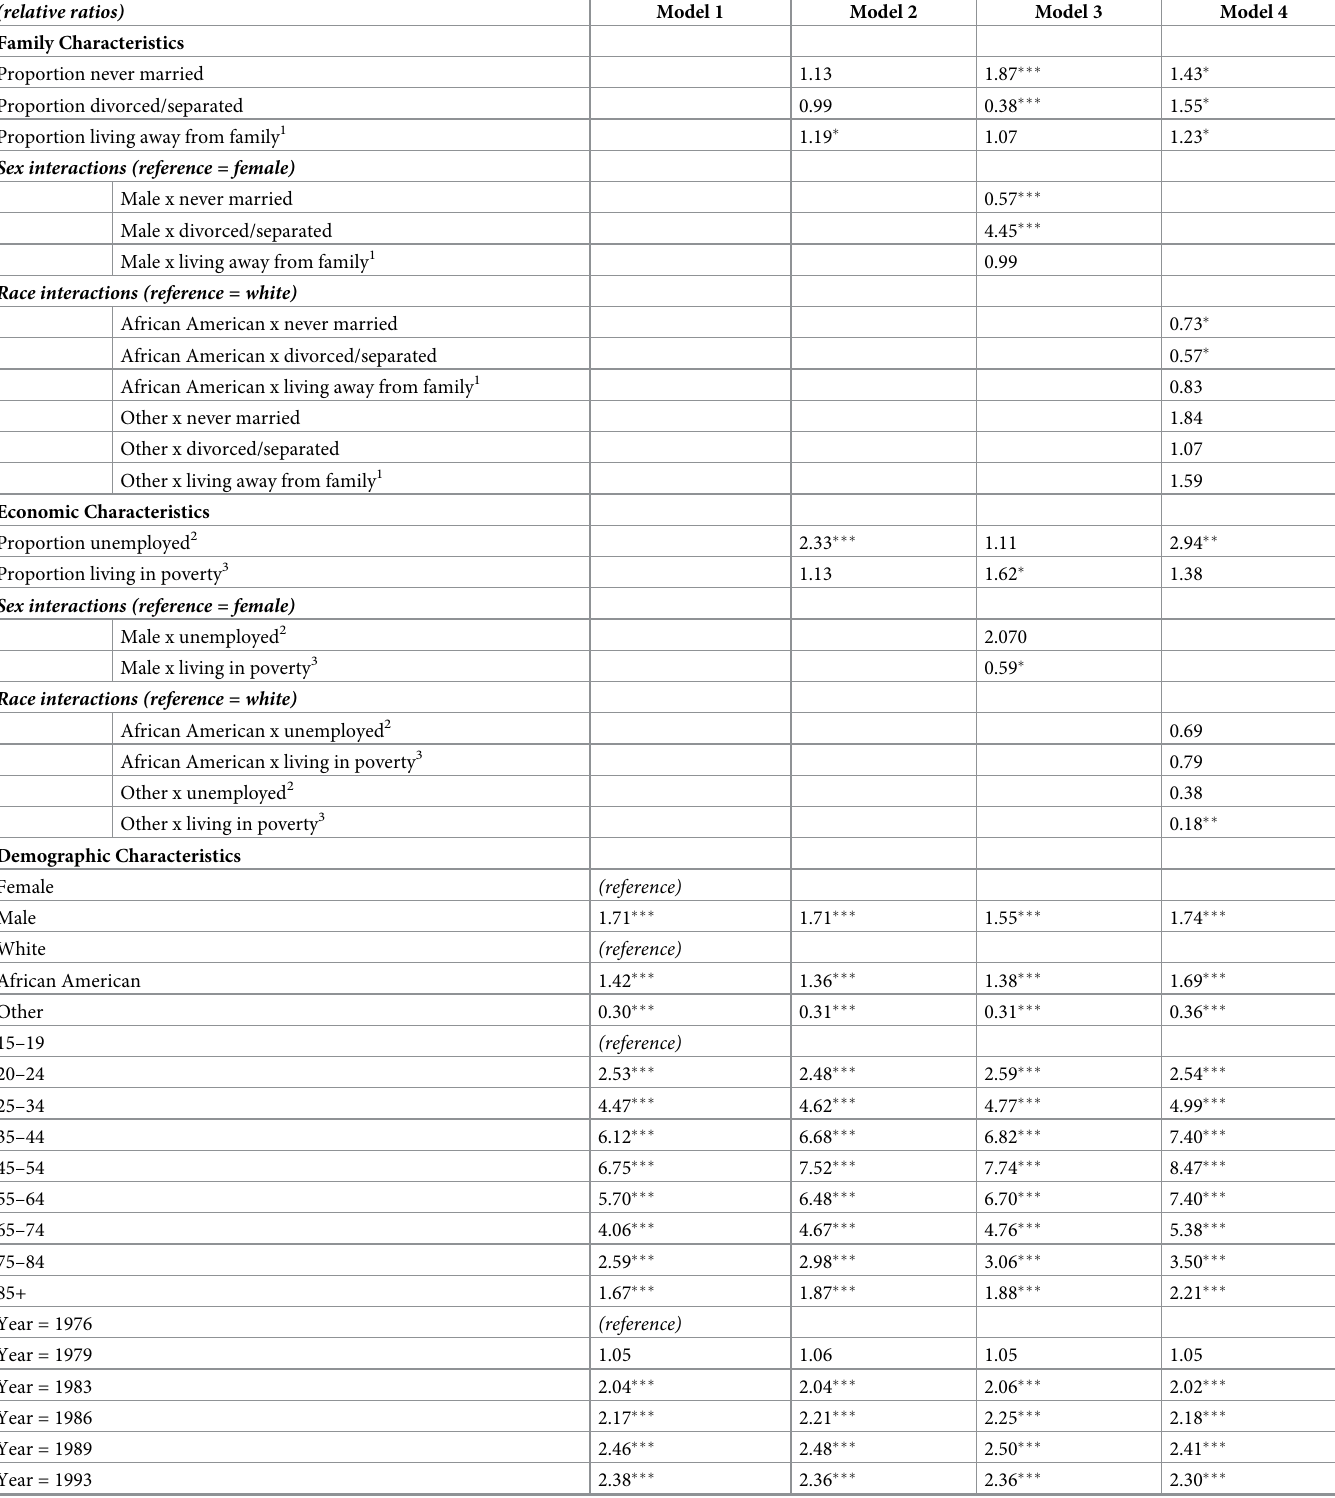
Table 3. Poisson estimation of relative rates of bodies being unclaimed by family and economic characteristics